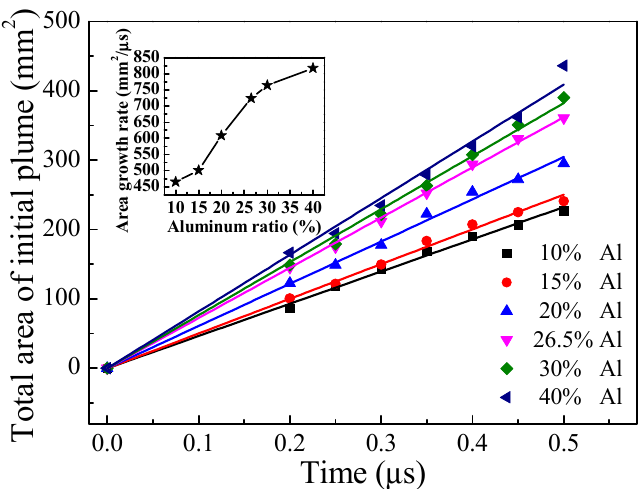
Figure 11. The total area of initial plume variation with time and its linear fitting at different proportions of Al (ambient pressure 0.005 Pa and laser energy 542.3 mJ).